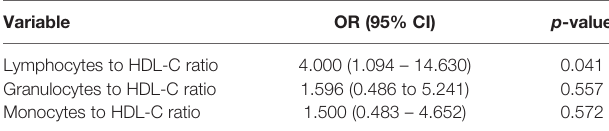
TABLE 7 | Odds ratio (OR) of independent predictors accessing risk of gestational diabetes mellitus in women with GDM (n = 25) and pregnant control women (n =